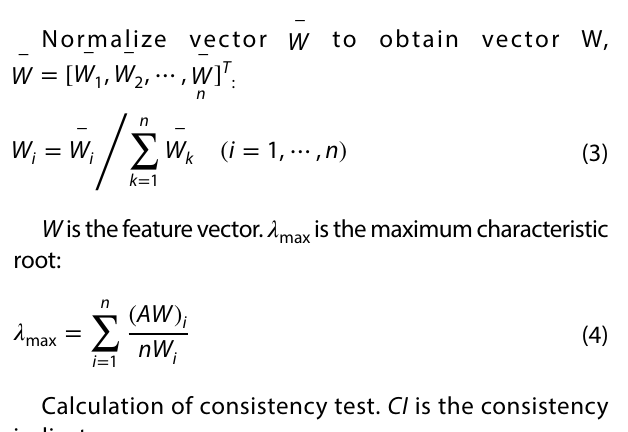
– means not applicable The data in the table are from the 39th